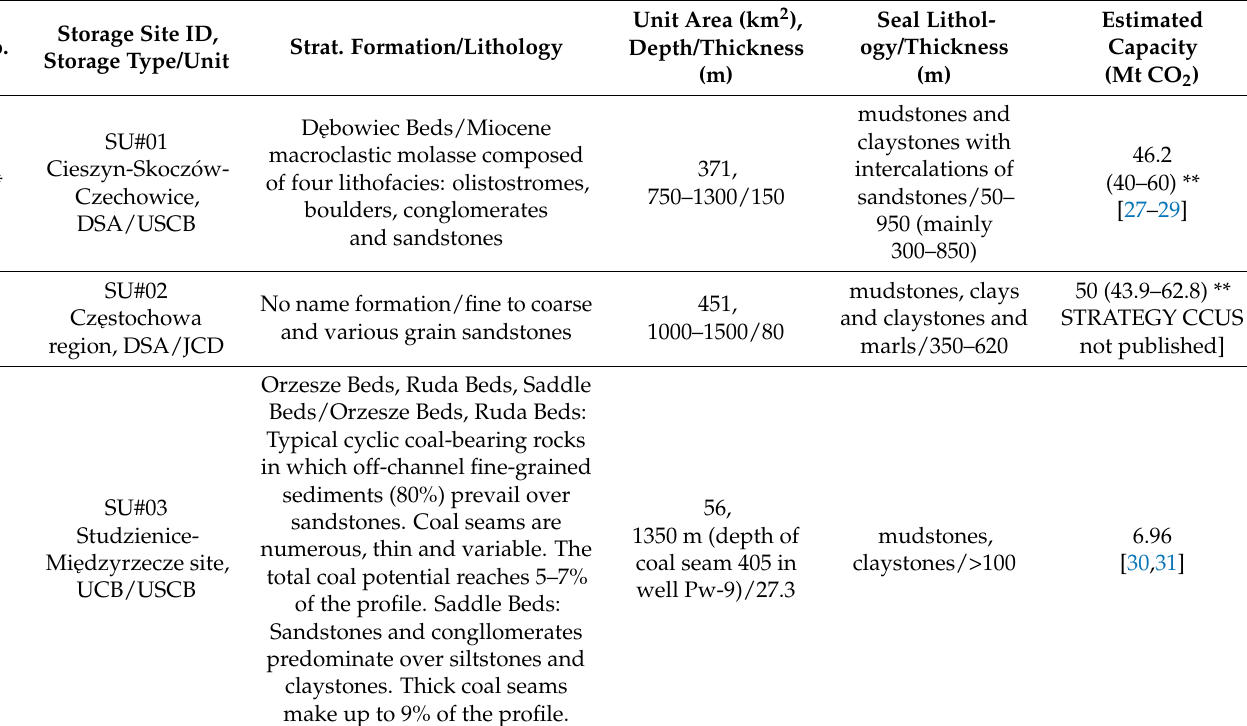
Table 2. General geological properties of selected CO 2 storage